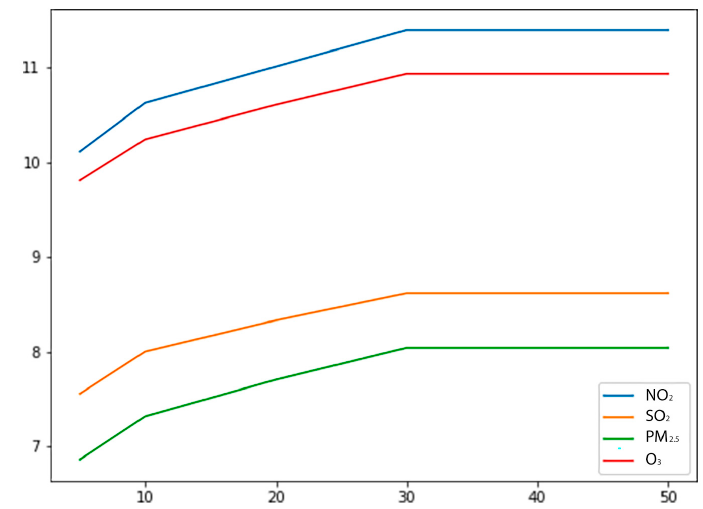
Figure 5. Annual ln($) saved from hospital admissions avoided due to air pollutant reductions that could accompany the five Superblocks scenarios.